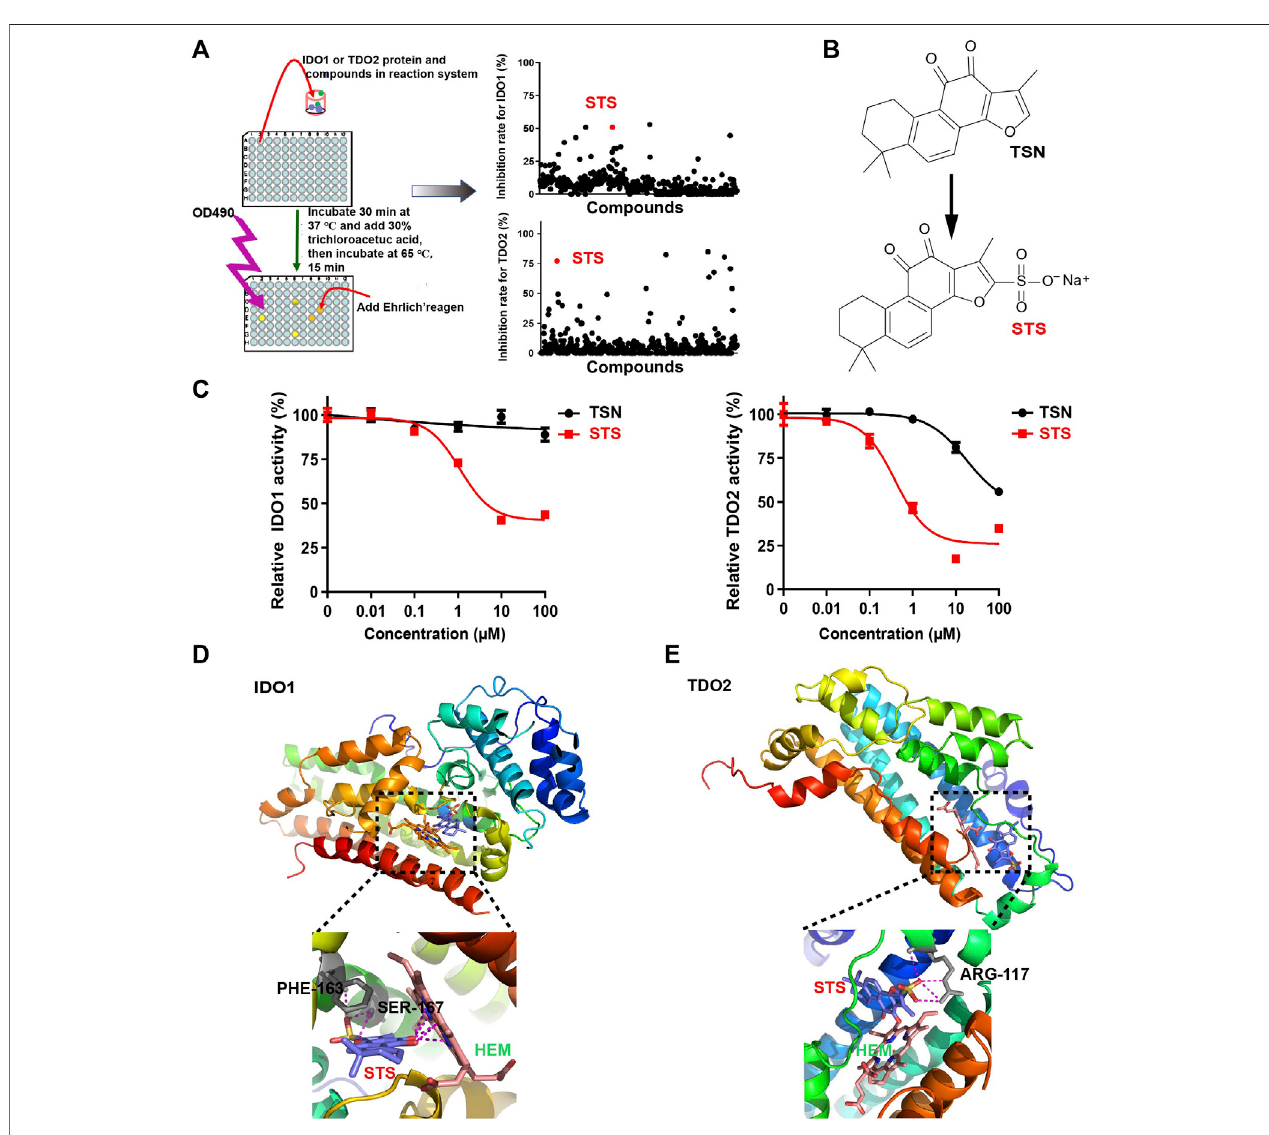
FIGURE1| STSinhibitedtheenzymaticactivityofIDO1andTDO2extracellularly. (A) The fl owchartdepictstheextracellularscreeningofIDO1andTDO2inhibitors. Theconcentrationofallcompoundswas10 μ M. (B) ThechemicalstructuresofSTSandTSN.ThesulfonicacidgroupwasusedtoimprovetheTSN ’ shydrophilicity. (C) Evaluation of IDO1 and TDO2 enzymatic activity in vitro . STS or TSN was added at the indicated concentrations, with three replicates for each concentration. (D,E) Molecular docking of IDO1 or TDO2 with STS. Amino acid residues that interacted with STS are colored gray, and their names are colored black.STS is marked in red and hemin (HEM) is marked in green. Red in STS represents oxygen atoms. Yellow in STS represents sulfur atoms.